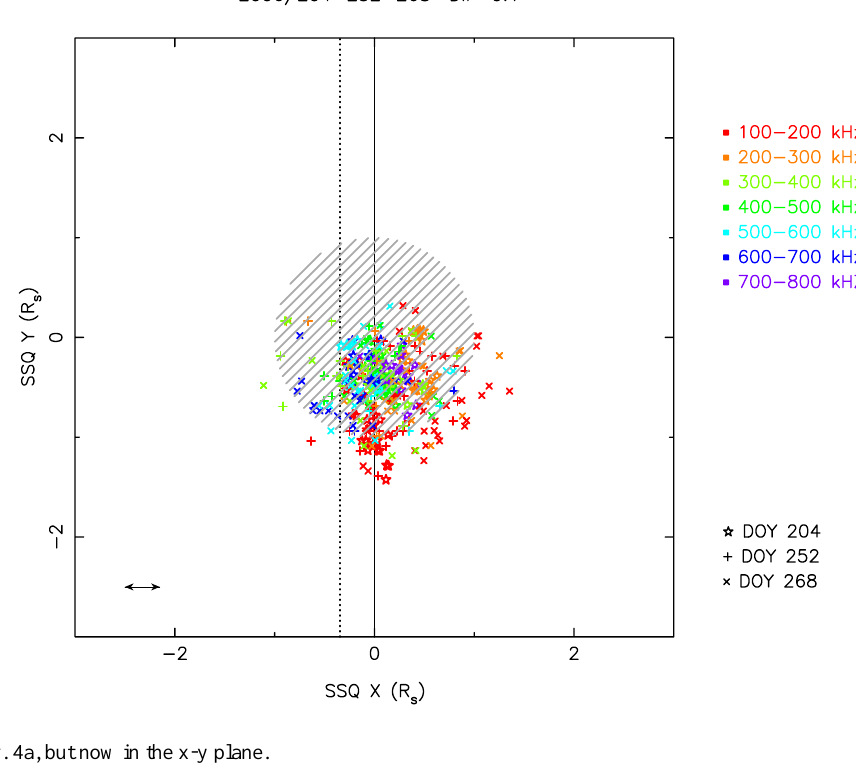
Fig. 4b. Same as Fig. 4a, but now in the x-y plane. Table 1. Summary of DF